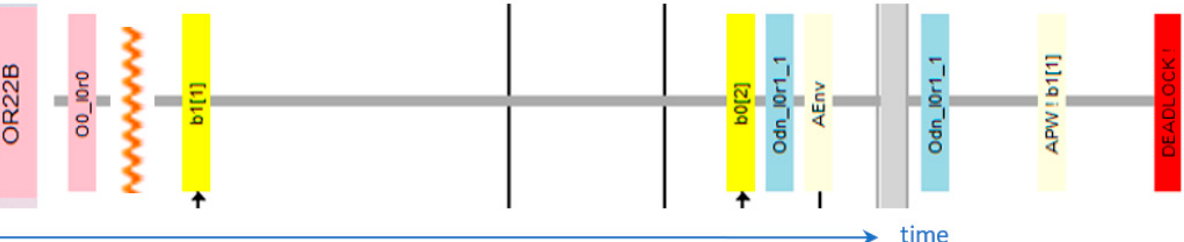
Figure 10. Action sequence in OR22B element, leading to error (unhandled message).